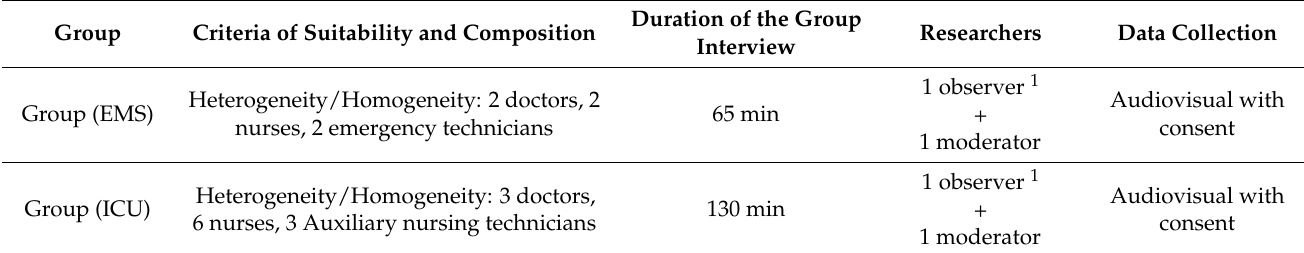
Table 2. Structure, composition and characteristics of the focus